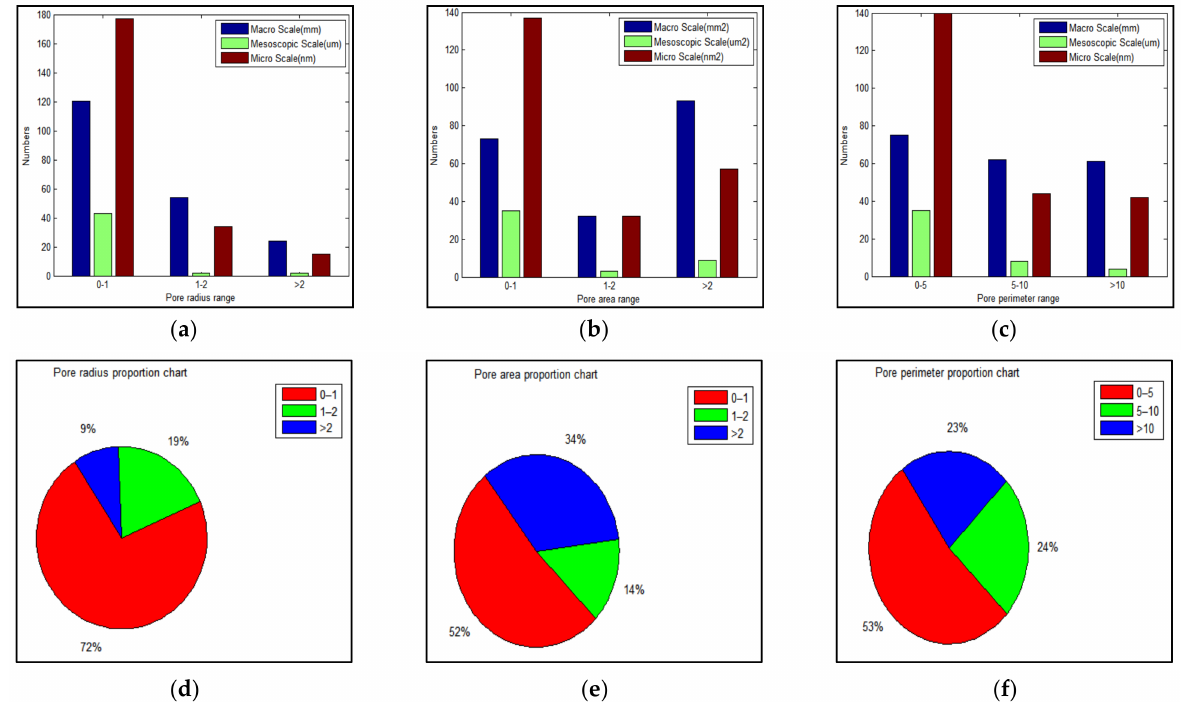
Figure 11. Distribution of characteristic parameters of multi-scale pore structure. ( a ) Radius quantity distribution histogram; ( b ) Area quantity distribution histogram; ( c ) Perimeter quantity distribution histogram; ( d ) Radius quantity distribution proportion diagram; ( e ) Area quantity distribution proportion diagram; ( f ) Perimeter quantity distribution proportion